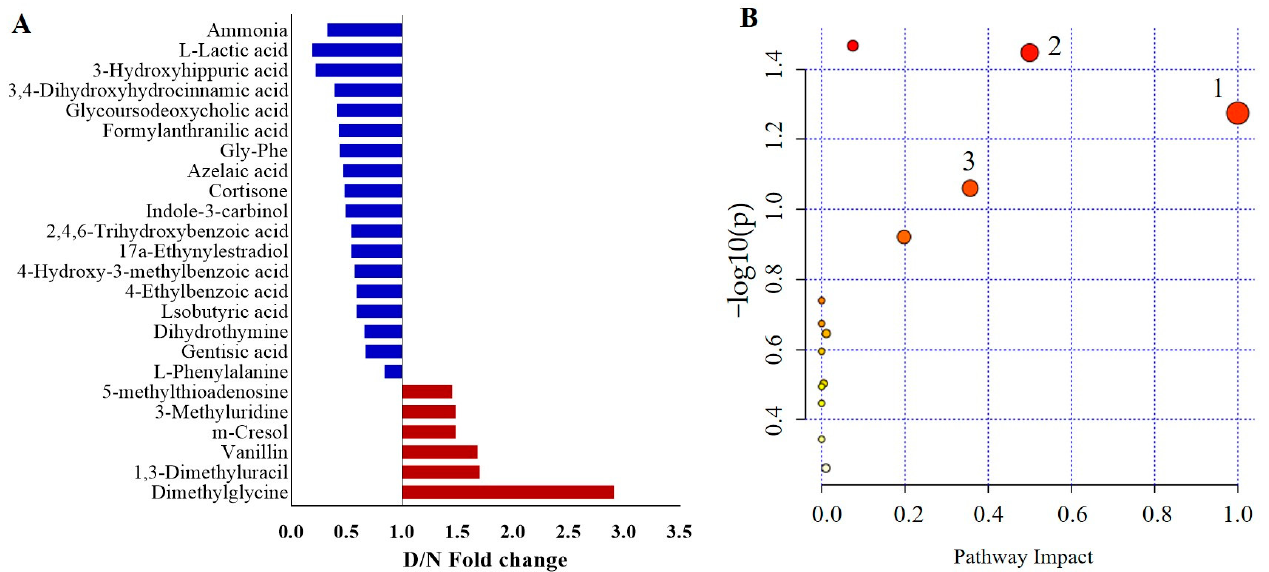
Figure 1. Differential metabolites ( A ) and metabolic pathways ( B ) between ScD and HC groups; Note: FC > 1 means the metabolite is up-regulated in ScD. FC < 1 means the metabolite is down-regulated; 1, nitrogen metabolism; 2, phenylalanine, tyrosine, and tryptophan biosynthesis; 3, phenylalanine metabolism.